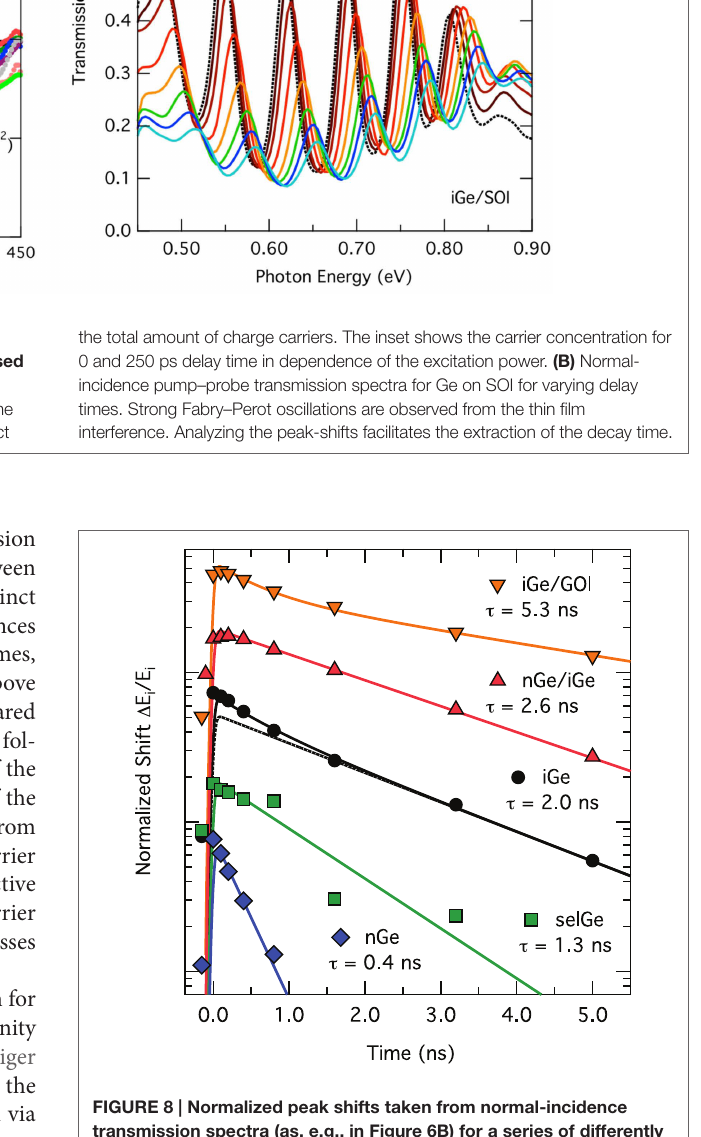
FiGURe 8 | Normalized peak shifts taken from normal-incidence transmission spectra (as, e.g., in Figure 6B) for a series of differently prepared Ge layers: iGe, nGe, selGe refers to intrinsic, n -doped, and selectively grown Ge, respectively . GOI refers to Ge on insulator. The non- radiative lifetime is obtained through an exponential fit to the data (Geiger et al., 2014a).